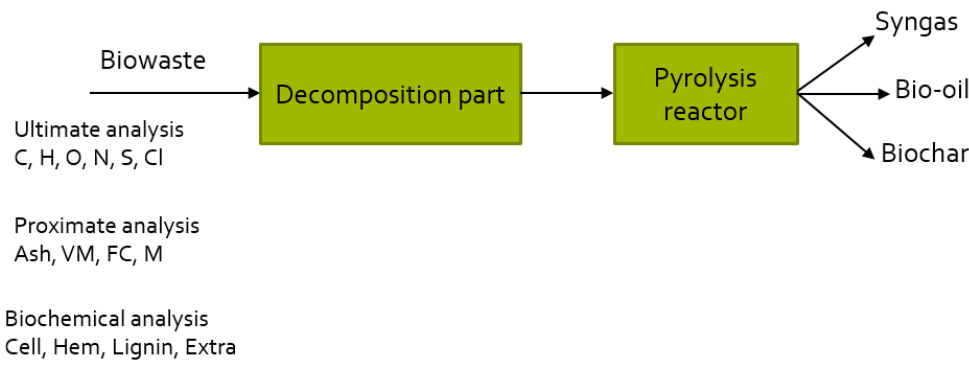
Figure 3. Main parts for simulation of biomass pyrolysis.